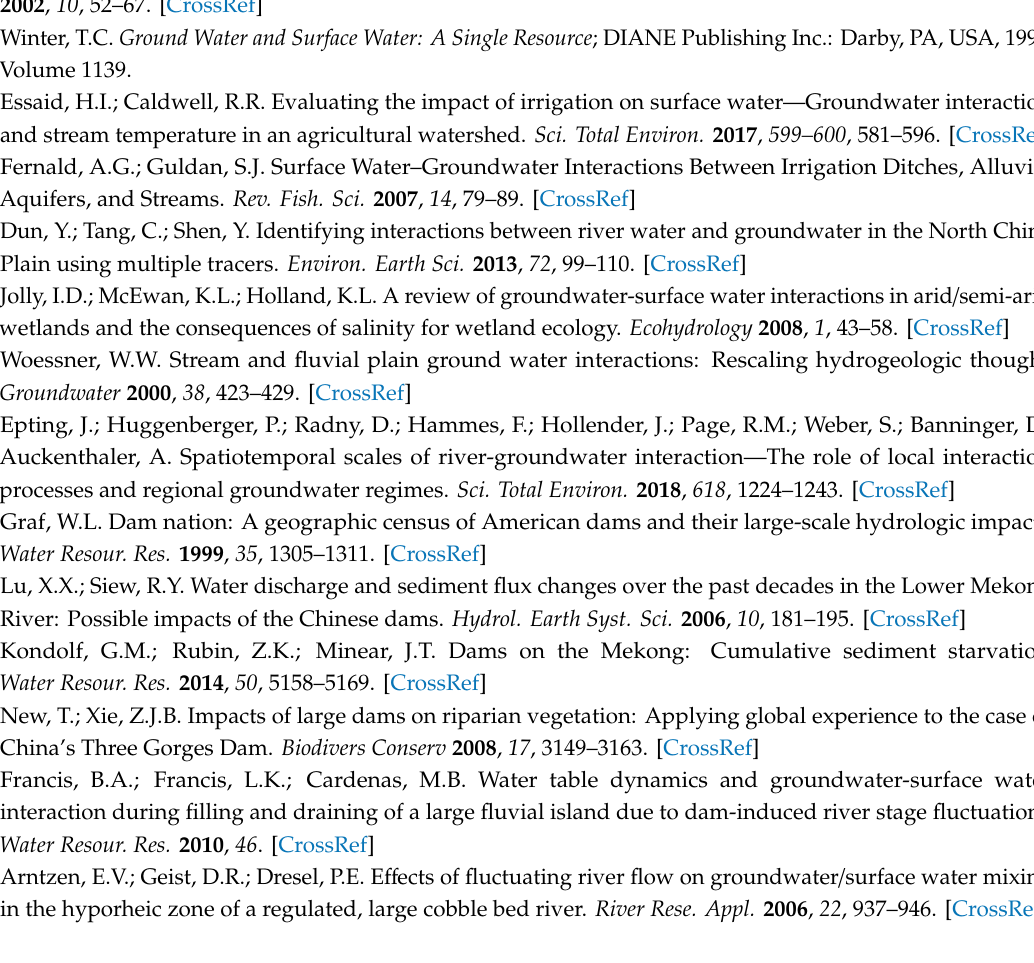
Table S1: Major ions and stable isotope concentrations in surface water and groundwater in 1959, Table S2: Major ions and stable isotope concentrations in surface water and groundwater in